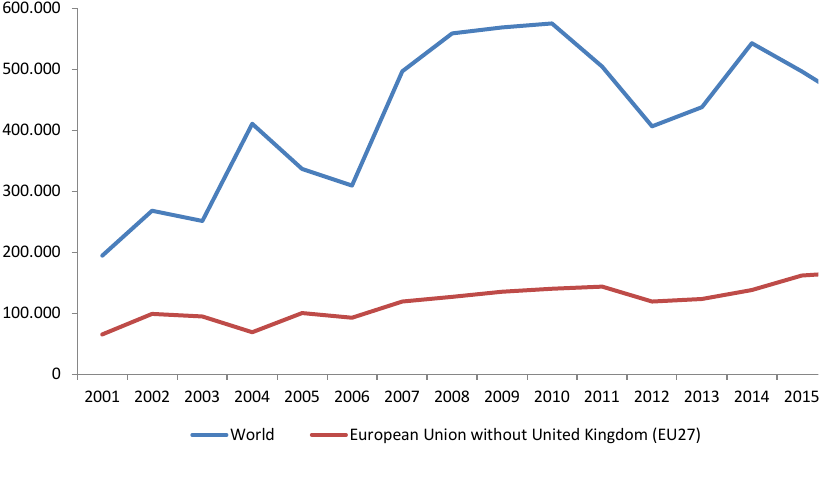
Figure 1. Evolution of global and EU imports under tariff subheading 1207.99 for the years 2001 to 2016 (in metric tonnes). Source: Own elaboration using data obtained from Trade Map